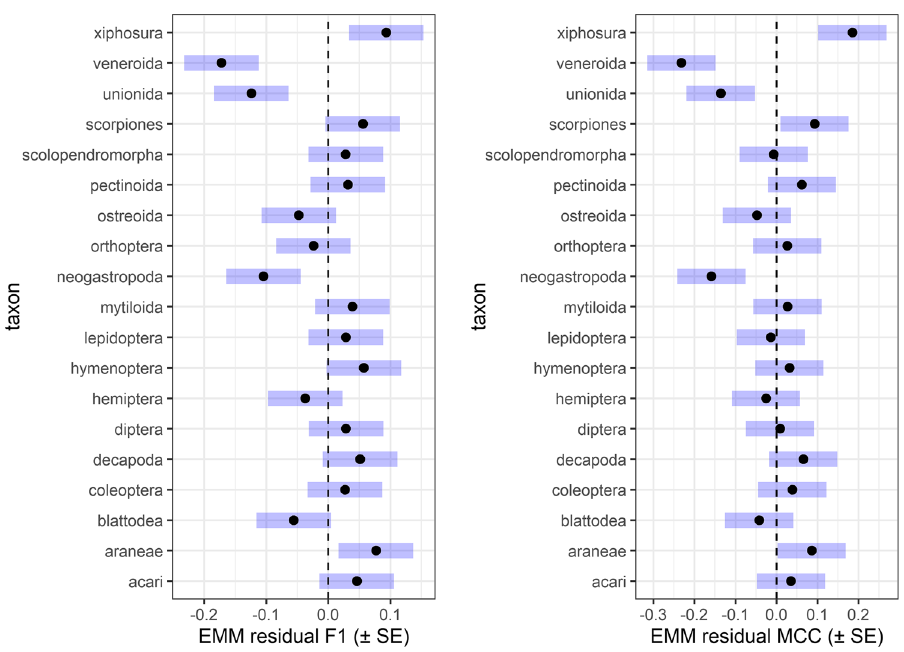
Figure 3. To check whether or not there were any taxa for which AMP predictions were consistently biased regardless of the used prediction tool we calculated "residual" F 1 and Matthew’s correlation coefficient (MCC) scores. These residual measures are simply the difference between the F 1 or MCC score of a given tool for a given taxon, and the arithmetic mean F 1 or MCC for the given tool, averaged over all taxa within that tool. Hence, if for example a taxon would generally have low prediction successes across all tools, we would see that this taxon has consistently low (below zero) residual values in each tool. We would expect to see that these residual scores are normally distributed around zero when there is no such effect. To see if these residual F 1 and MCC values have a mean significantly different from zero, estimated marginal means (EMM) were calculated by fitting a linear regression model with residual F 1 and MCC as responses and taxon as categorical predictor. This figure depicts EMMs (black dots) and their standard errors (SE: blue horizontal bars); SE bars not crossing zero (dashed line) can be considered as the given EMM statistically significantly differing from zero (at α =